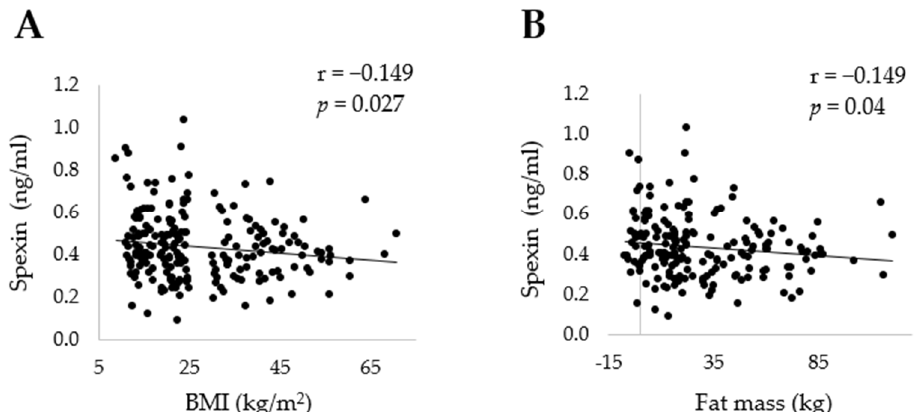
Figure 1. Correlations of spexin with ( A ) BMI and ( B ) fat mass (kg) in the whole study population. Negative fat mass values in bioelectrical impedance analysis are possible in severely underweight patients, due to the manufacturer’s algorithms being calculated primarily for normal weight subjects. Abbreviation: BMI, body mass index.